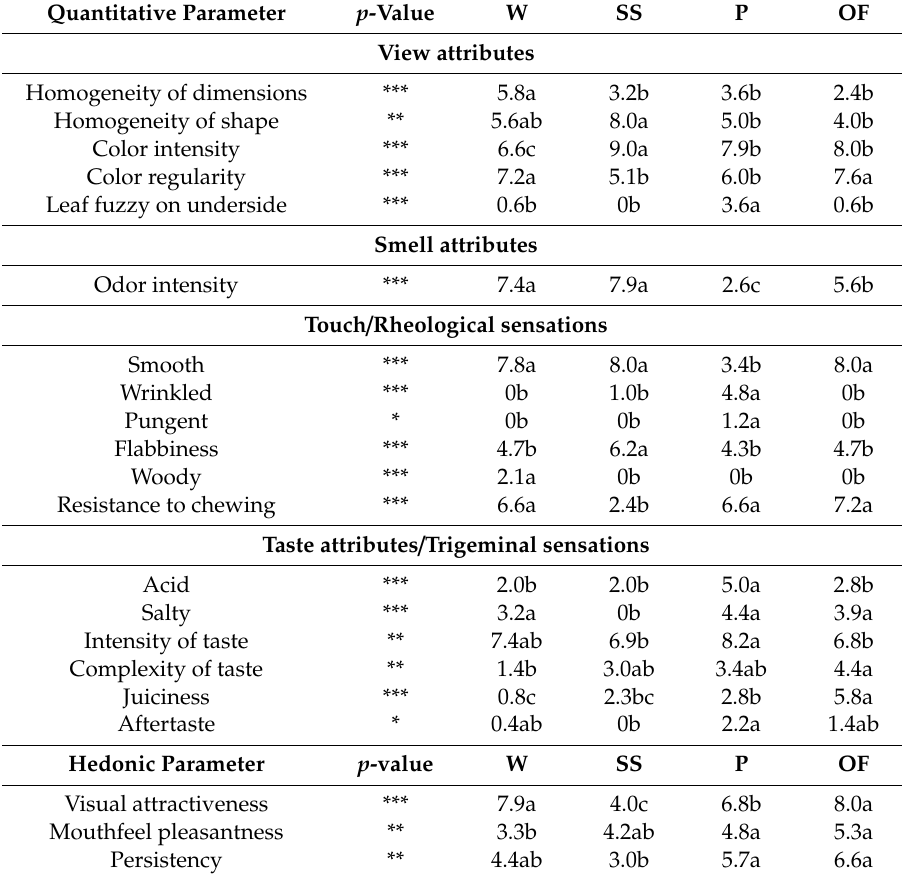
Table 2. Two-way ANOVA calculated for all quantitative and hedonic parameters evaluated by panelists during tasting sessions for Cichorium intybus. Only data that showed significant di ff erences ( p < 0.05) are reported. Means keyed with a di ff erent letter are significantly di ff erent for p = 0.05, considering each species independently and following one-way ANOVA, with wild-collection or the di ff erent domestications as the variability factor. Significance level: ***: p < 0.001 (F = 7.94); **: p < 0.01 (F = 4.77); *: p < 0.05 (F =